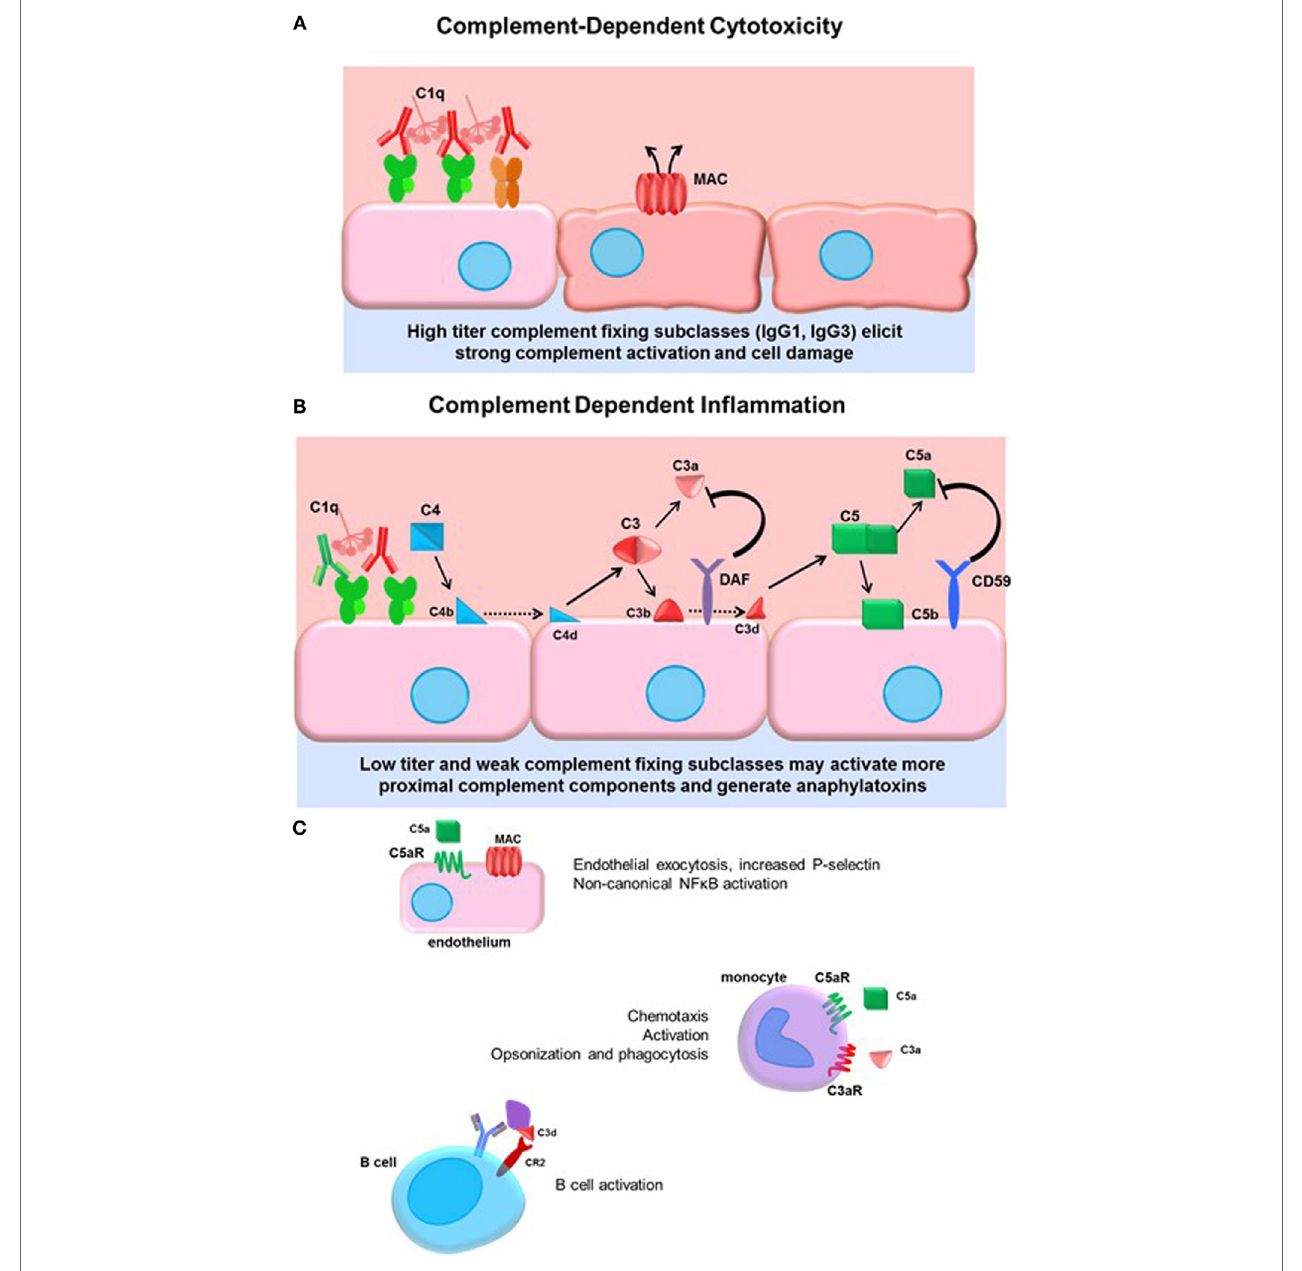
FiGURe 2 | Complement-dependent cytotoxicity and inflammation . (A) High titers of antidonor HLA antibodies, particularly of the efficient complement-fixing subclasses IgG1 and IgG3, may promote terminal classical complement pathway activation. Complement activation must overcome the regulatory factors and push complement activation to terminal MAC formation and cell damage. (B) Lower titers of antibody or less efficient complement-fixing subclasses, such as IgG2, may result in truncated complement activation, with upstream anaphylatoxin release and opsonin deposition. The initiator C1 complex, composed of globular C1q, embedded with catalytically active C1r and C1s, recognizes the Fc portion of IgM and most of the IgG subclasses, triggering a conformational change in the hexameric shape of the C1 complex. This activates the autocatalytic cleavage of C1r, which then activates C1s. C4 and C2 are cleaved by C1s, forming C4a and C2a split products that generate the C3 convertase. C3 convertase cleaves C3 protein into C3a, a soluble inflammatory protein, and C3b, which is covalently bound to the cell surface. C3b may be further cleaved to C3d or form the C5 convertase. Terminal activation of the C5 convertase cleaves C5 protein, generating the potent anaphylatoxin C5a and the membrane-bound C5b. C5b recruits C6–9 proteins to form the membrane attack complex (MAC), disrupting membrane integrity. Complement regulatory proteins DAF and CD59 at the host cell surface restrain activation of the complement cascade at the two key amplification steps, C3 cleavage and C5 cleavage. (C) Many cells express receptors for the soluble and membrane-bound complement split products. Endothelial cells respond to C5a by upregulating P-selectin, and to sublytic concentrations of MAC by activation of non-canonical NF κ B pathways, adhesion molecule, and cytokine upregulation. Monocytes and neutrophils express C3a and C5a receptors, which participate in chemotaxis of myeloid cells. Complement receptor 2 (CR2) is a component of the BCR that binds to opsonized, C3d-coated antigen. CR2 signaling enhances the BCR signal and lowers the threshold for B cell activation.